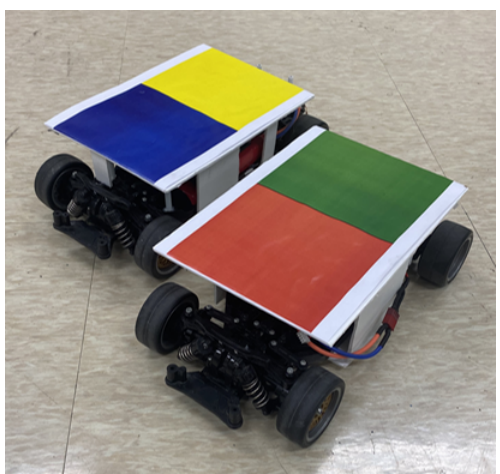
Figure 15. Experimental environment.